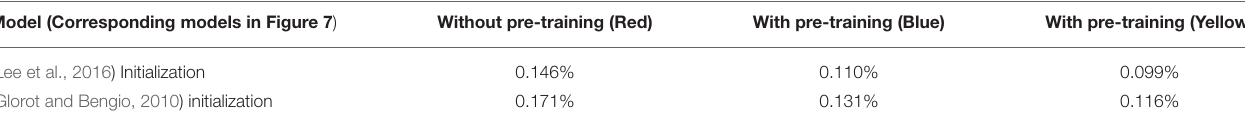
TABLE 4 | Mean standard deviation of classification errors that are initialized with different weight initialization schemes in deep multi-layer networks. Model (Corresponding models in Figure 7 ) Without pre-training (Red) With pre-training (Blue) With pre-training (Yellow) (Lee et al., 2016) Initialization 0.146% 0.110% 0.099% (Glorot and Bengio, 2010) initialization 0.171% 0.131%